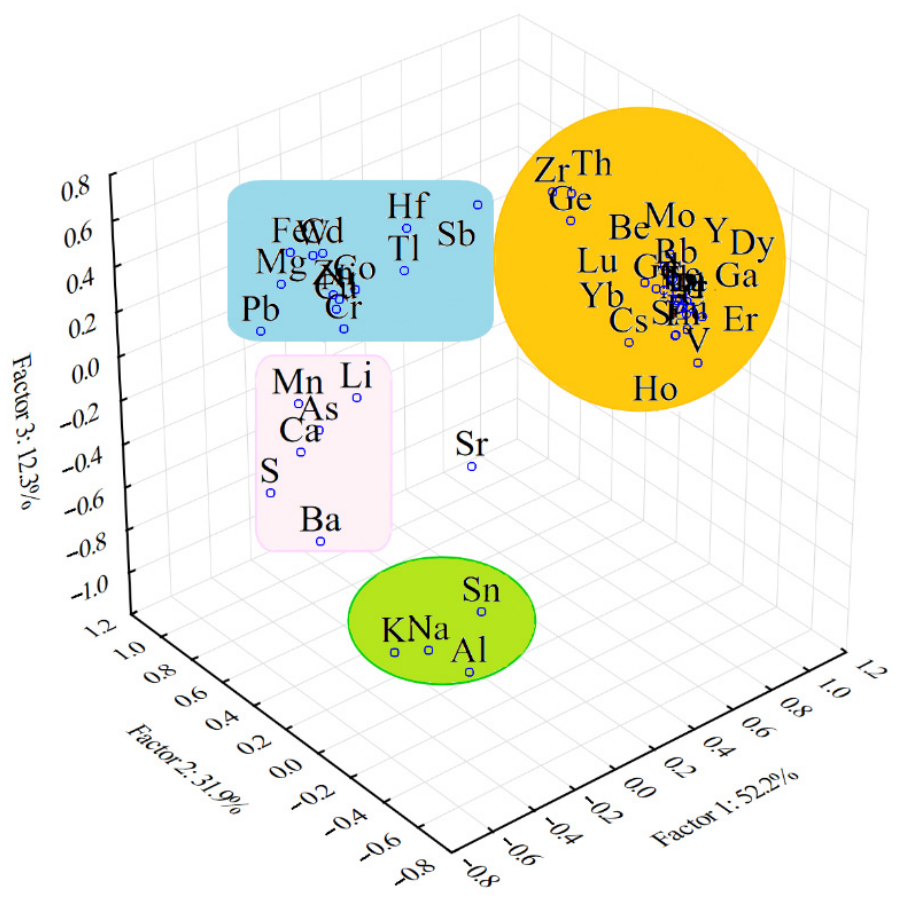
Figure 6. Three-dimensional Varimax-rotated PCA showing the grouping and interrelationships between the elements in the silty soil samples collected from Clos